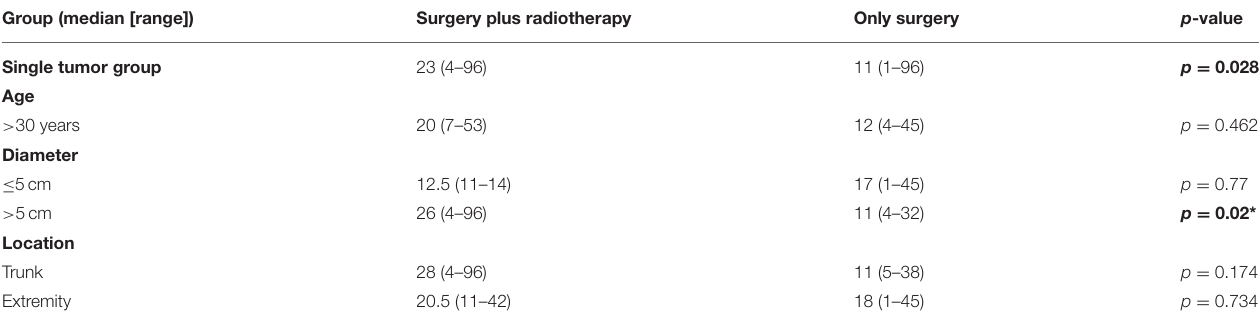
TABLE 4 | TTR comparison between surgery plus radiotherapy and only surgery in single tumor group. Group (median [range]) Surgery plus radiotherapy Only surgery p -value Single tumor group